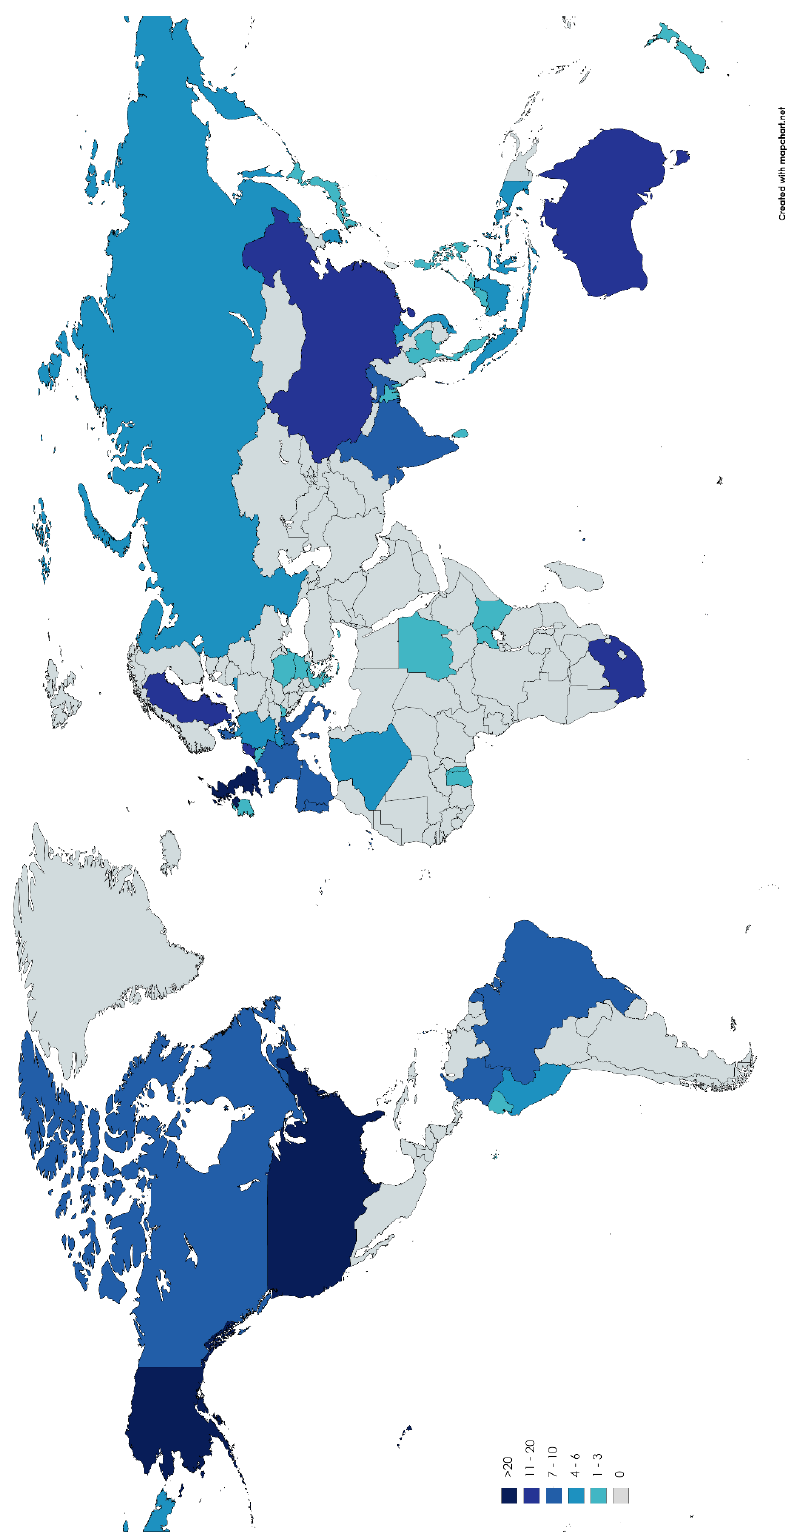
Figure A1. Geographical distribution and study frequency according to authors’